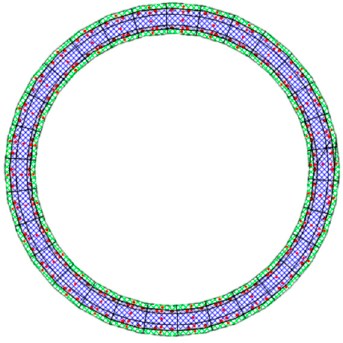
Figure 8. Sectional mesh of caisson in this study.